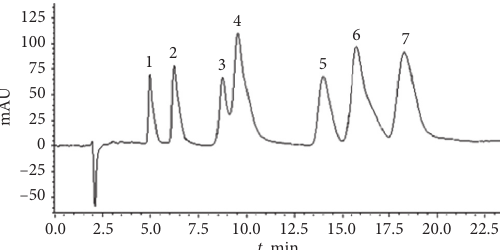
Figure 7: Chromatogram of a mixture of PA on a column with sorbent-4. Acids (15 μ g/ml): 1, sorbic; 2, nicotinic; 3, vanillic; 4, gallic; 5, p -coumaric; 6, ferulic; 7,